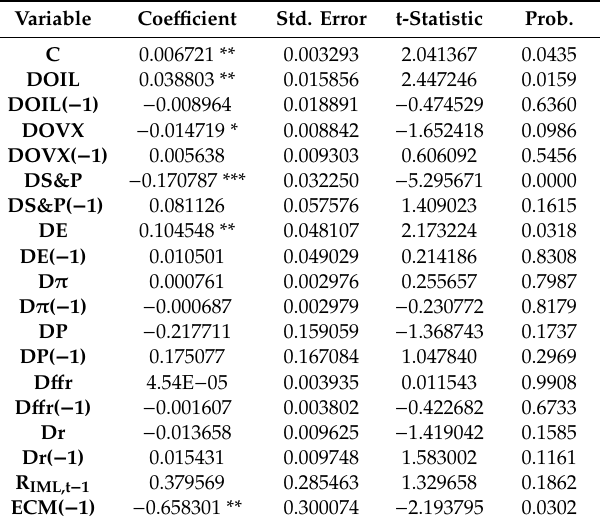
Table 16. Short-run error correction model (full